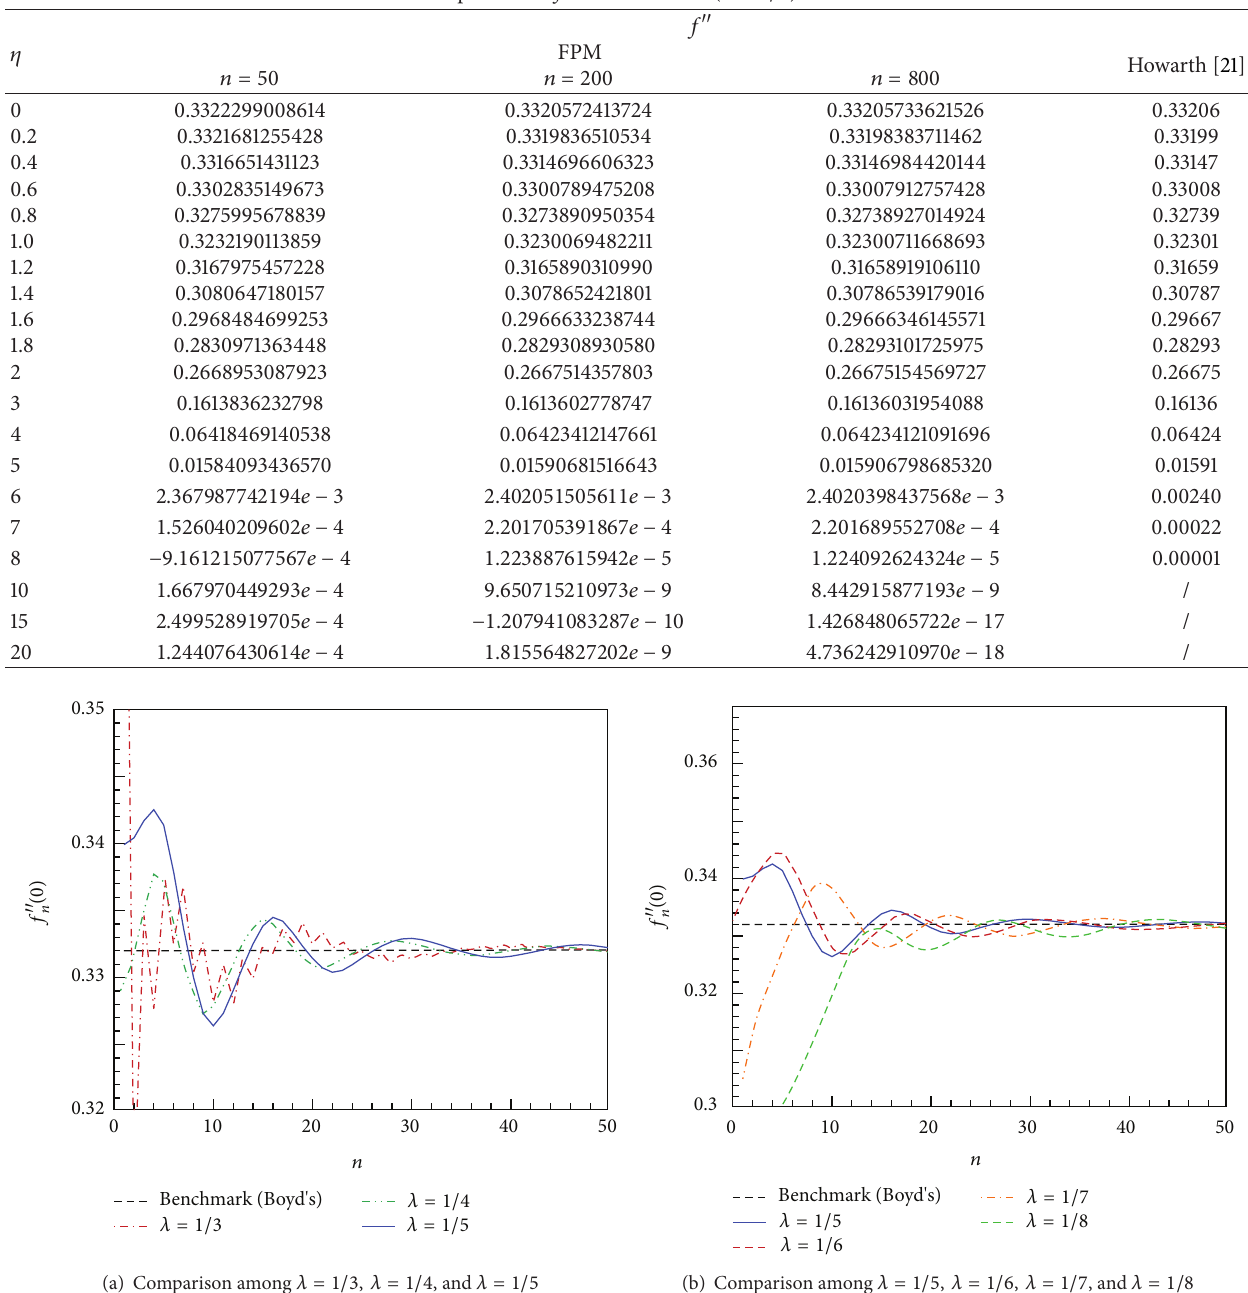
Table 4: Comparison of 𝑓 󸀠󸀠 between FPM ( 𝜆 = 1/5 ) and Howarth.